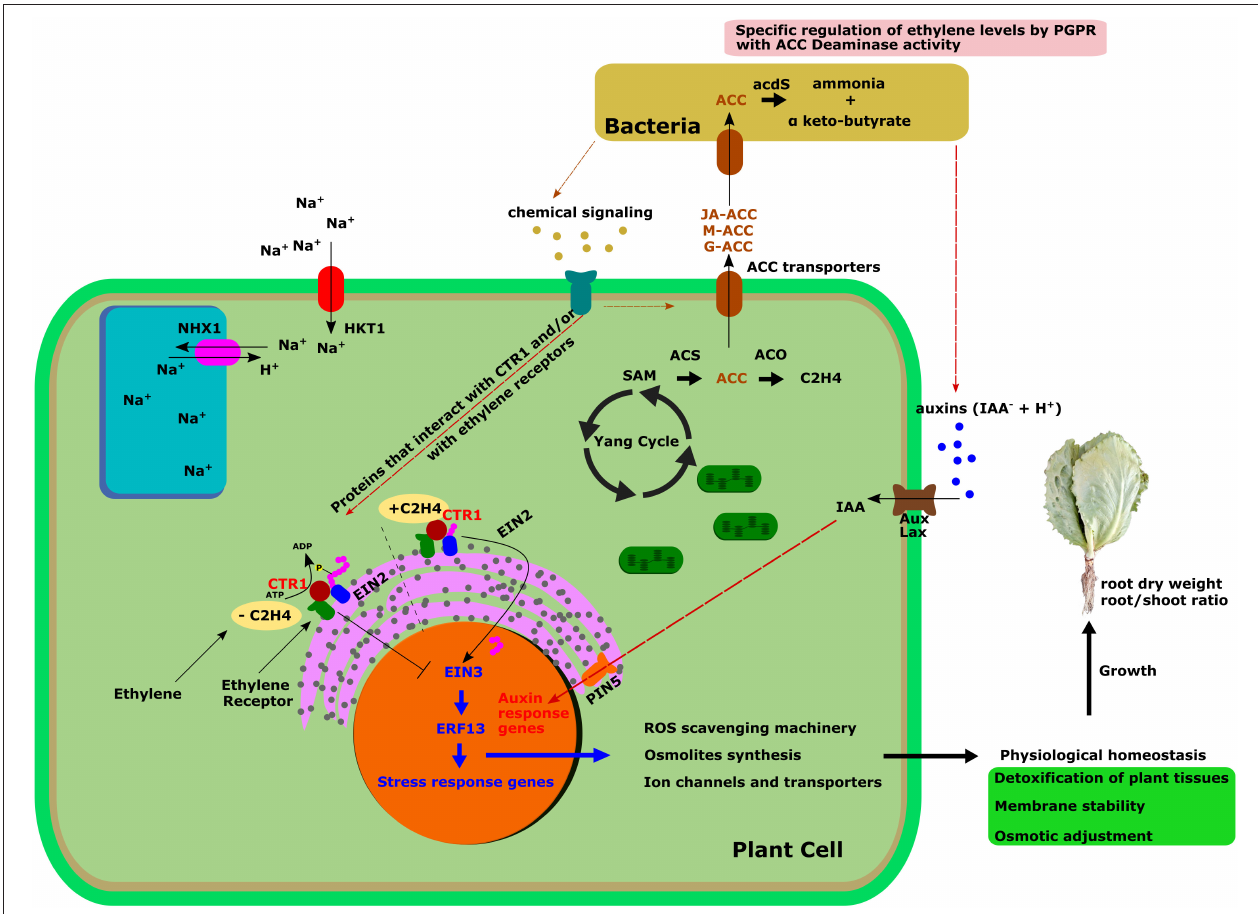
FIGURE 5 | Graphical synthesis for integrated regulation of the ethylene signaling pathway upon PGPR-plant interaction, and its effects on plant homeostasis and growth. Ethylene signaling pathway is directly affected by inoculation with bacteria, which establishes a chemical communication with the plant cell. Specific molecules secreted by bacteria would bind plant receptors, inducing activation or synthesis of plant molecules which in turn would induce changes in the expression of genes involved in ethylene signaling. By this way, bacteria would up- and down-regulate key genes involved in the ethylene response, inducing a better response of the plant to salt stress, in comparison with Control plants, as reflected in an enhanced membrane stability (evaluated as lipid peroxidation), proline content and plant biomass. Brown colored pathway represents the established model of ethylene synthesis modulation by plant-bacteria interaction, postulated by Glick et al. (1998), based on degradation of ethylene precursor ACC by bacterial ACC deaminase activity. ACC, 1-aminocyclopropane-1-carboxylate; acdS , ACC deaminase; M-ACC, Malonyl-ACC; G-ACC, γ -glutamyl-ACC; JA-ACC, Jasmonoyl-ACC; NHX1, Vacuolar Na + /H + antiporter; HKT1, High affinity K + transporter; SAM, S-adenosyl-L-methionine; ACS, ACC-synthase; ACO, ACC-oxidase; C 2 H 4 , Ethylene; CTR1, Constitutive Triple Response 1; EIN2 , Ethylene-Insensitive 2; EIN3 , Ethylene-Insensitive 3; EBF1 , EIN3 -binding F-box protein 1-like; ERF13 , Ethylene-Responsive transcription Factor 13; ROS, Reactive Oxygen Species;